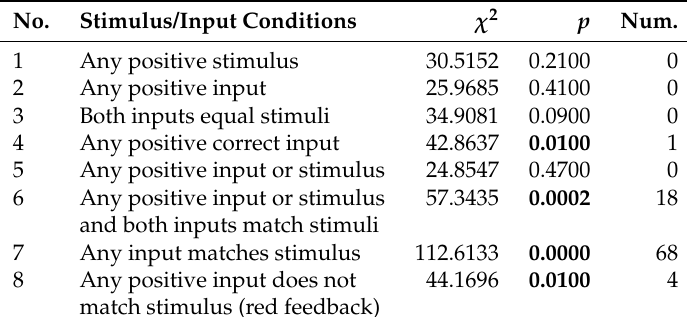
Table 1. The χ 2 (critical value (CV)) and p -value ( χ 2 > CV) of the most significant feature (smallest p ) for each stimulus/input condition, and the number of features (Num.) exceed the significance level.